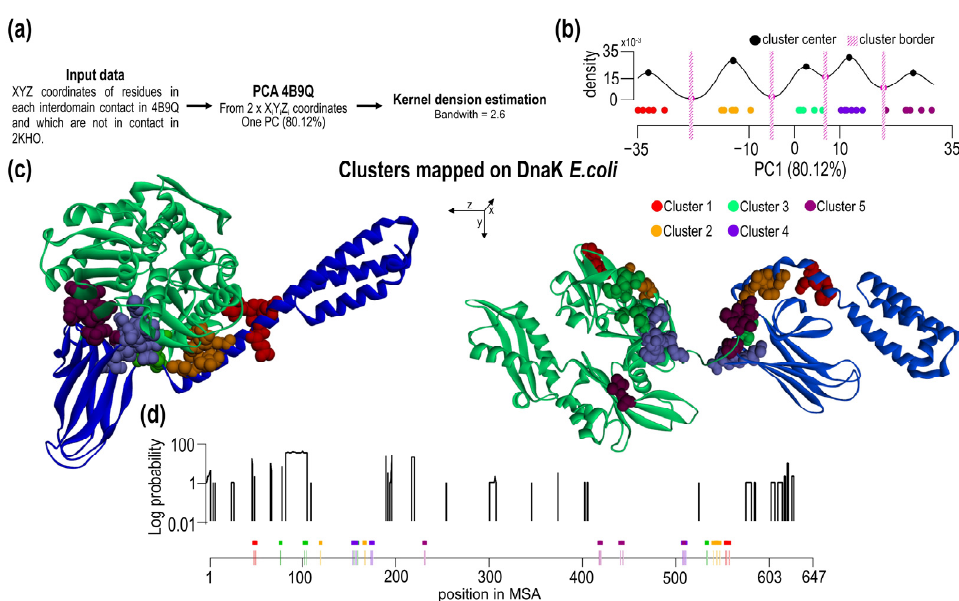
Figure 5. Clustering of contact residues. ( a ) Workflow of cluster analysis. ( b ) Kernel density estimation of PC1 data (see also Supplementary Figure S7). Based on density, we found five clusters of contact residues. ( c ) 3D structures of open and close conformation of E. coli DnaK with visualized clusters. Structures are aligned across the z -axis. In this axis are residues distributed. ( d ) Probability of indels in positions of Proteobacteria and Firmicutes MSA. Schematic MSA positions show the distribution of contact residues in MSA with corresponding clusters.